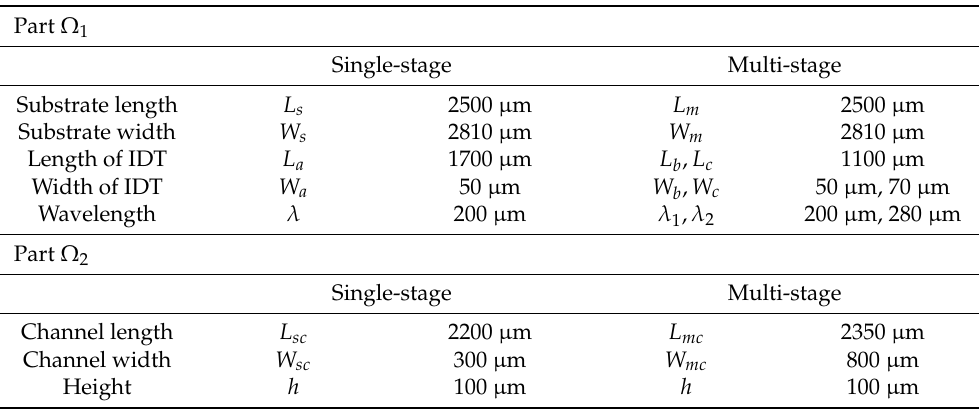
Table 1. Model parameters.